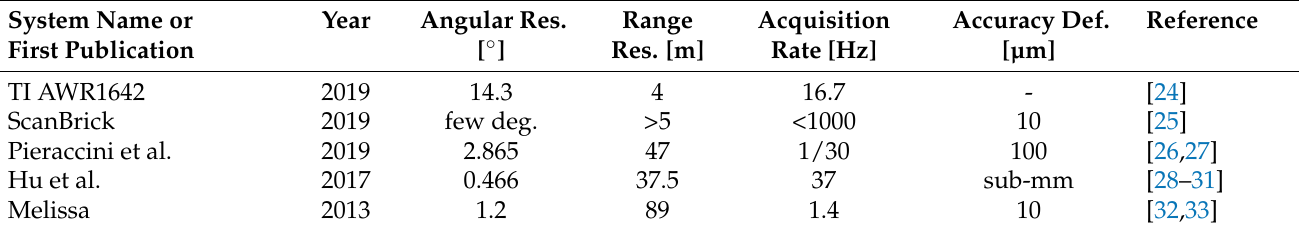
Table 1. MIMO-SAR systems for